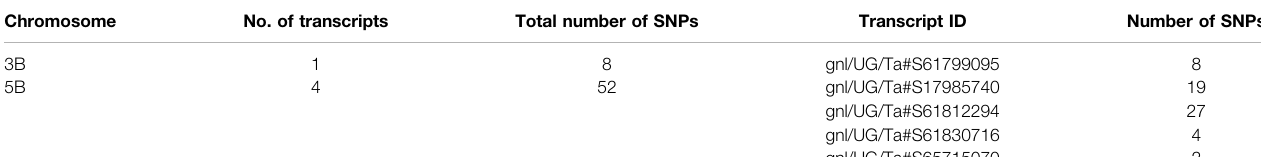
TABLE 5 | Transcripts of 3B and 5B chromosomes having SNPs markers of SB resistance with BFR > 6. Chromosome